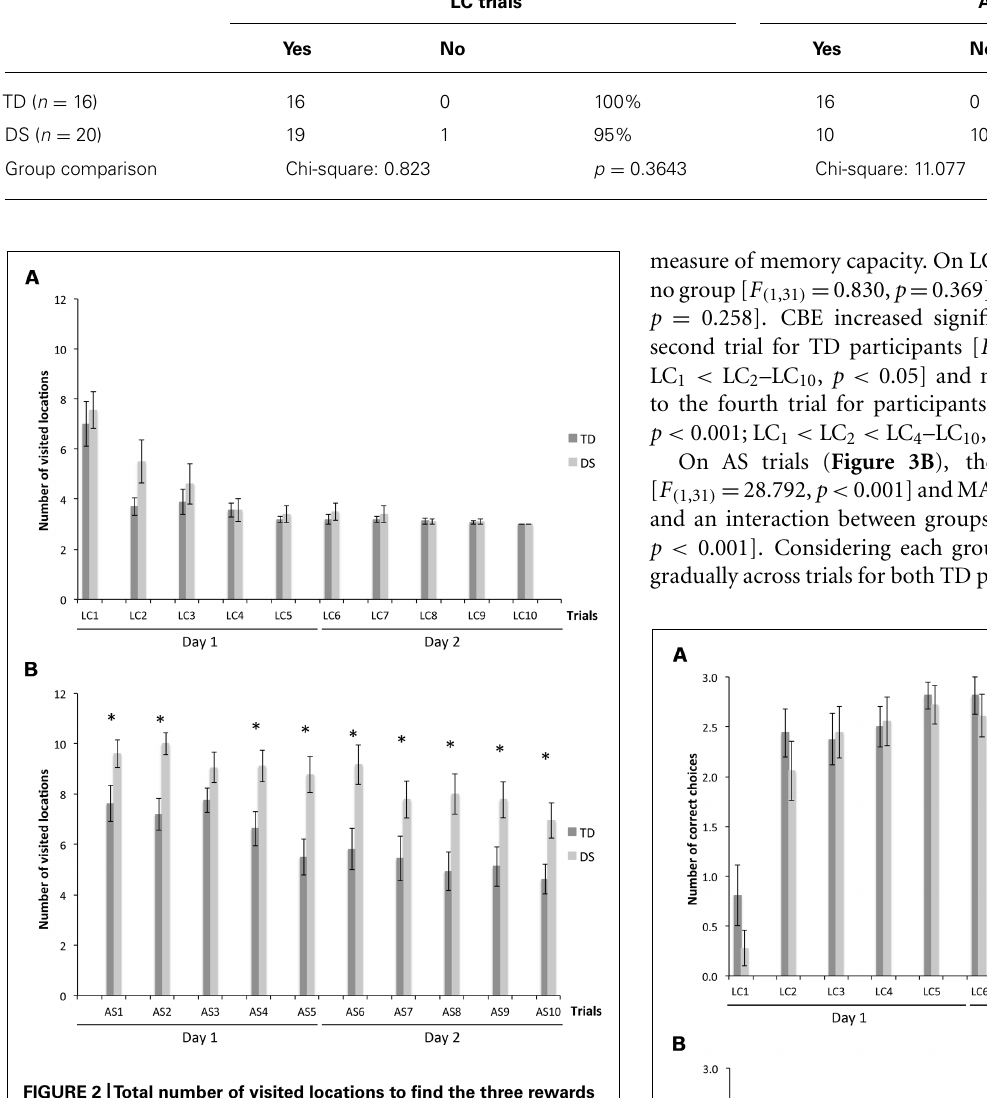
FIGURE 2 |Total number of visited locations to find the three rewards (TNV). (A) LC trials. (B) AS trials.The asterisks denote statistically significant group differences on a given trial at p < 0.05.